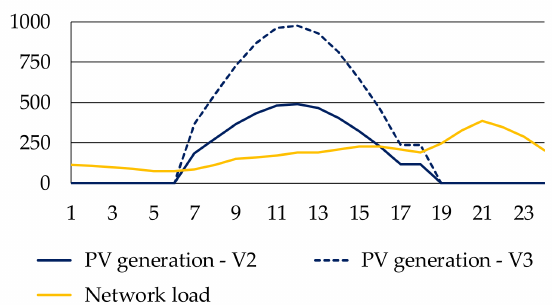
Figure 13. Total daily load and total PV generation (kW) in the CIGRE test network.